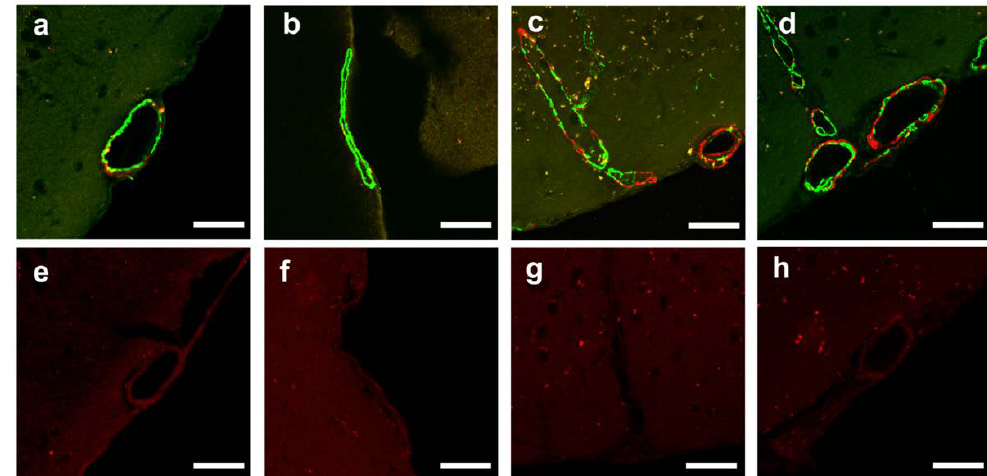
Figure 2. Upper line ( a – d ): Serial confocal microscopic changes of double-immunolabeled vessels (green, smooth muscle actin; red, amyloid). Lower line ( e – h ): Confocal microscopic findings represent negative controls without primary antibody for Aβ . a, b, Leptomeningeal vessel in a 15-month-old mouse shows small amyloid deposition and focal loss of smooth muscle cells at the site of cerebrovascular amyloid; c, d, In a 23-month-old mouse, smooth muscle cells are lost, and a thick sheet of amyloid covers the wall of a leptomeningeal vessel. e-f, Photos of the negative controls for Aβ (each section adjacent to a, b, c, d, respectively) show only a faint background stain in the vessel walls. Scale bar: 50 µ m.